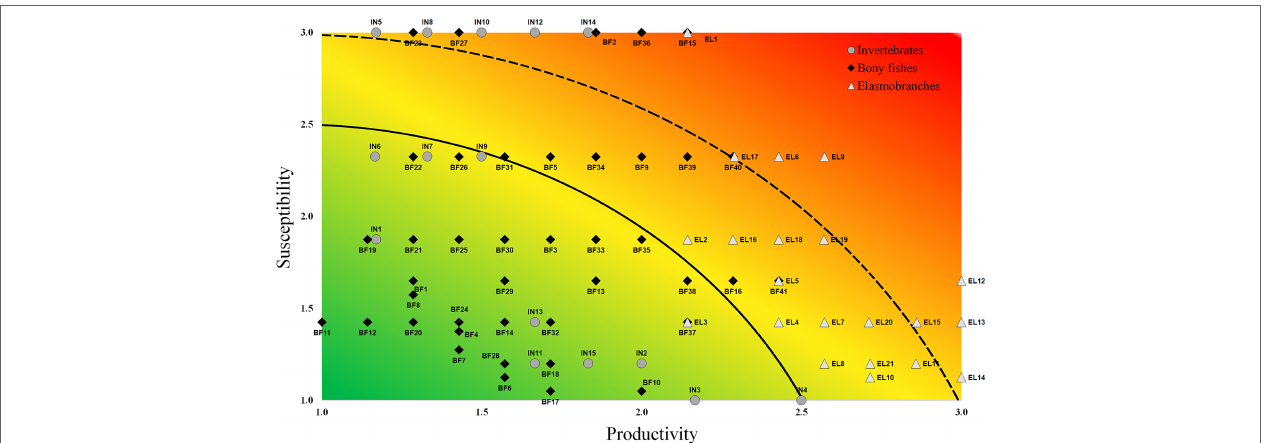
FIGURE 2 | Productivity and Susceptibility Analysis plot for species of high commercial importance in Mexican fisheries. Isopleths delimit areas of equal relative vulnerability, species with the highest vulnerability above the dotted line (V > 3.18), those with medium vulnerability above the solid line (2.64 < V < 3.18), and those with the lowest vulnerability below the solid line. See Table 3 for the point labels to identify the species in the